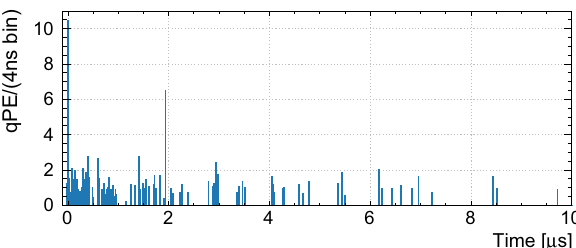
Fig. 1 A typical trace from an approximately 20 keV ee 39 Ar event. The pulses from all PMTs are shown together